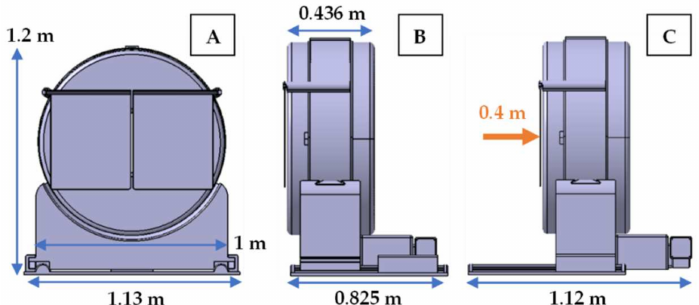
Figure 12. Major dimensions ( A ): front view (fully retracted); ( B ): side view (fully retracted), ( C ): (fully extended).